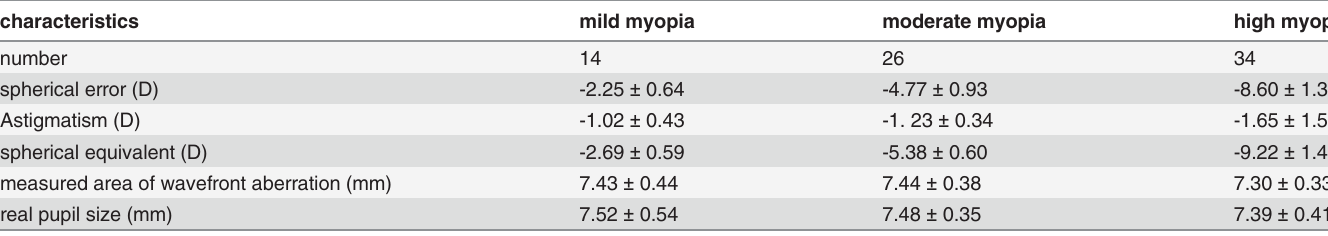
Table 1. Characteristics of uncorrected myopic eyes (mean ±